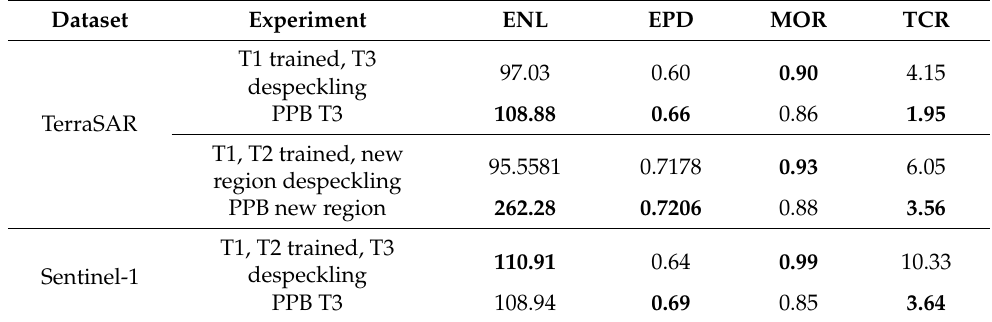
Table 4. Quantitative assessment results of the generalization